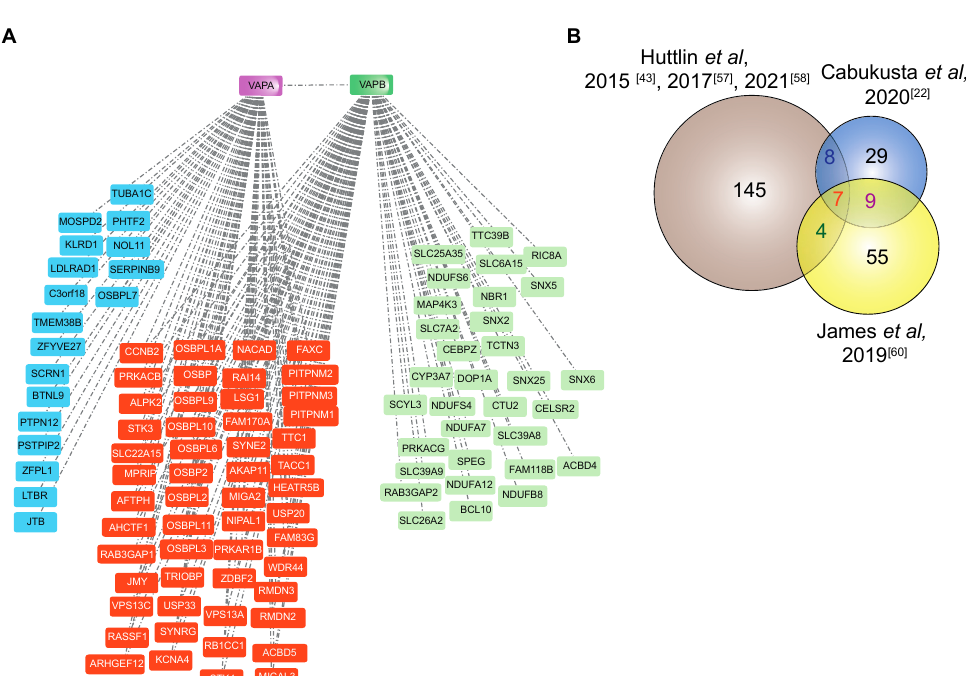
Figure 4. The interactome of VAPA and VAPB. ( A ) The Bioplex interaction network of both VAPA and VAPB in HEK293T cells reported by Huttlin et al. [43,57,58]. The proteins represented in blue are sole VAPA interactors, and those represented in green are sole VAPB interactors. The proteins represented in orange are common interacting partners of both VAPA and VAPB. ( B ) The Venn diagram shows VAPB interactors identified by Huttlin et al. (affinity purification-mass spectrometry) [43,57,58], by Cabukusta et al. (BioID followed by mass spectrometry identification) [22] and by James et al. (RAPIDS (rapamycin and apex dependent identification of proteins by SILAC) followed by mass spectrometry identification) [60]. See Table 1 for proteins that were identified in at least two